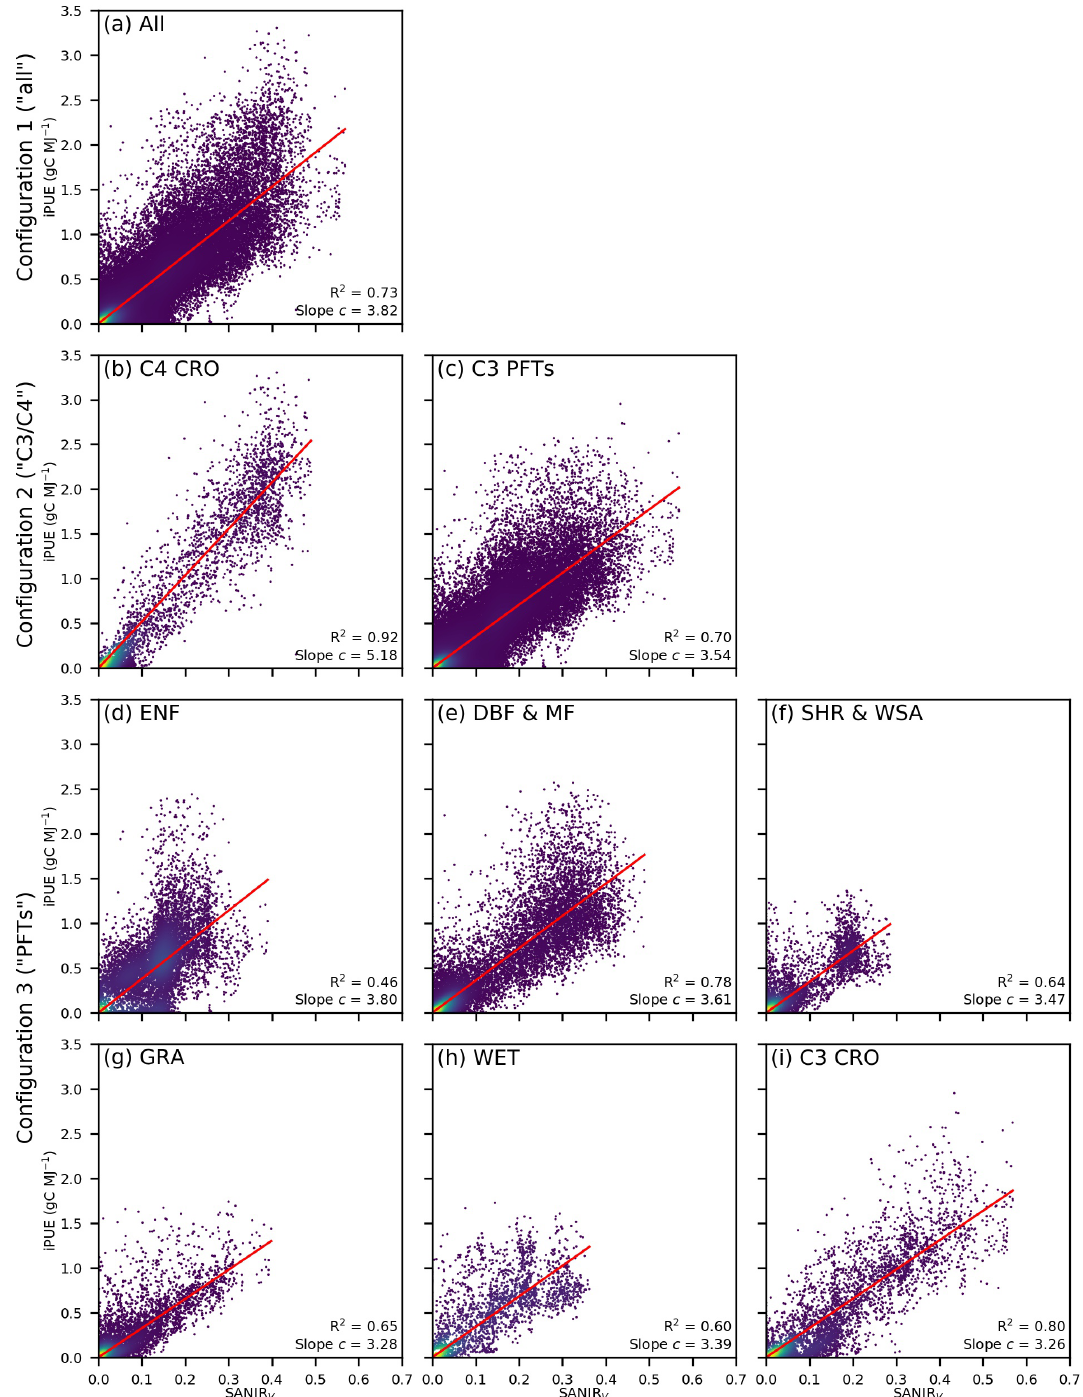
Figure 10. Comparison between SANIR V and iPUE over different subsets. The slope value of the SANIR V –iPUE relationship is the model parameter c (Eq. 5). Panel (a) is used by the model configuration 1 (all). Panels (b) and (c) are used by the model configuration 2 (C3–C4), which is actually used by SLOPE. Panels (b) and (d) – (i) are used by the model configuration 3 (PFTs).